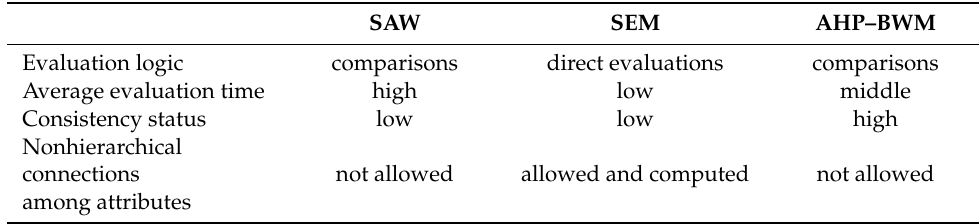
Table 14. Comparison of the proposed method with mainstream